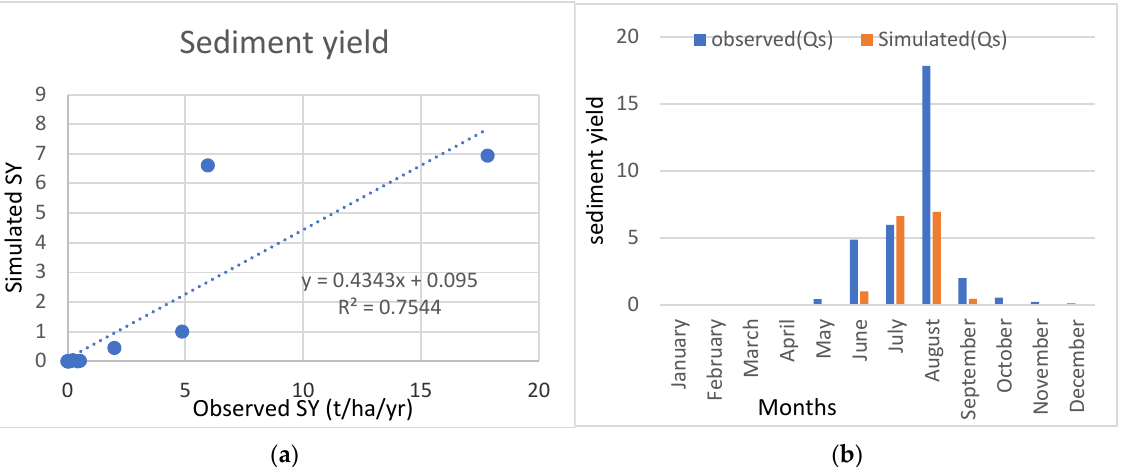
Figure 9. Validation period (2003–2004). ( a ) Observed versus simulated sediment yield; ( b ) Observed and simulated monthly sediment delivery rates.